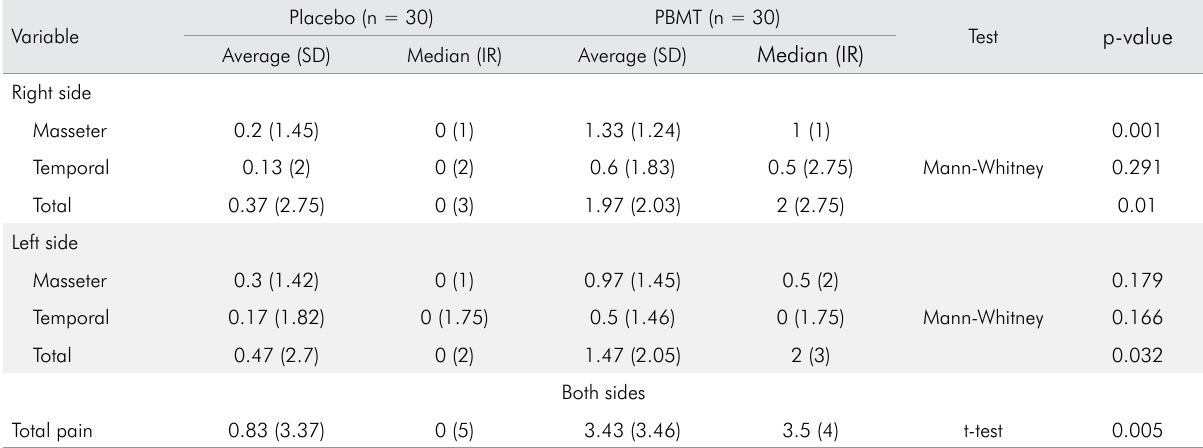
Table 3. Pain level differences between the first and second evaluations for PBMT and placebo treatments.